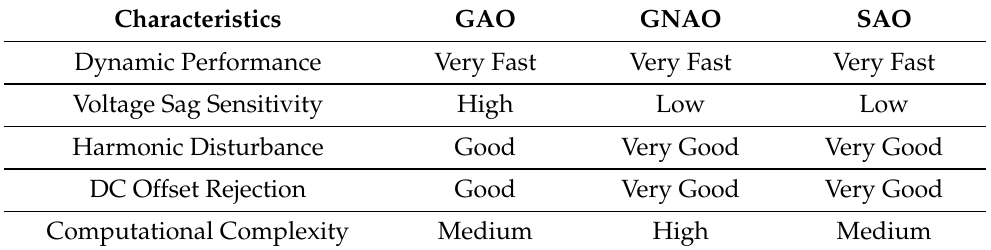
Table 1. Comparative analysis of the adaptive observer-based